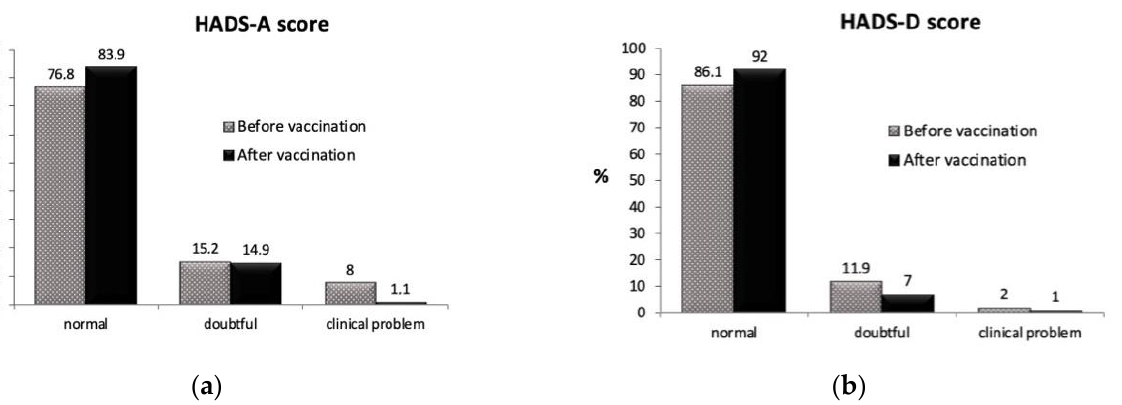
Figure 1. ( a ) Descriptive anxiety results in the HADS test in all participants before and after COVID- 19 vaccination. Chi-square test p = 0.05. ( b ) Descriptive depression results in the HADS test in all participants before and after COVID-19 vaccination. Chi-square test p = 0.80. After vaccination: two weeks after the second dose of